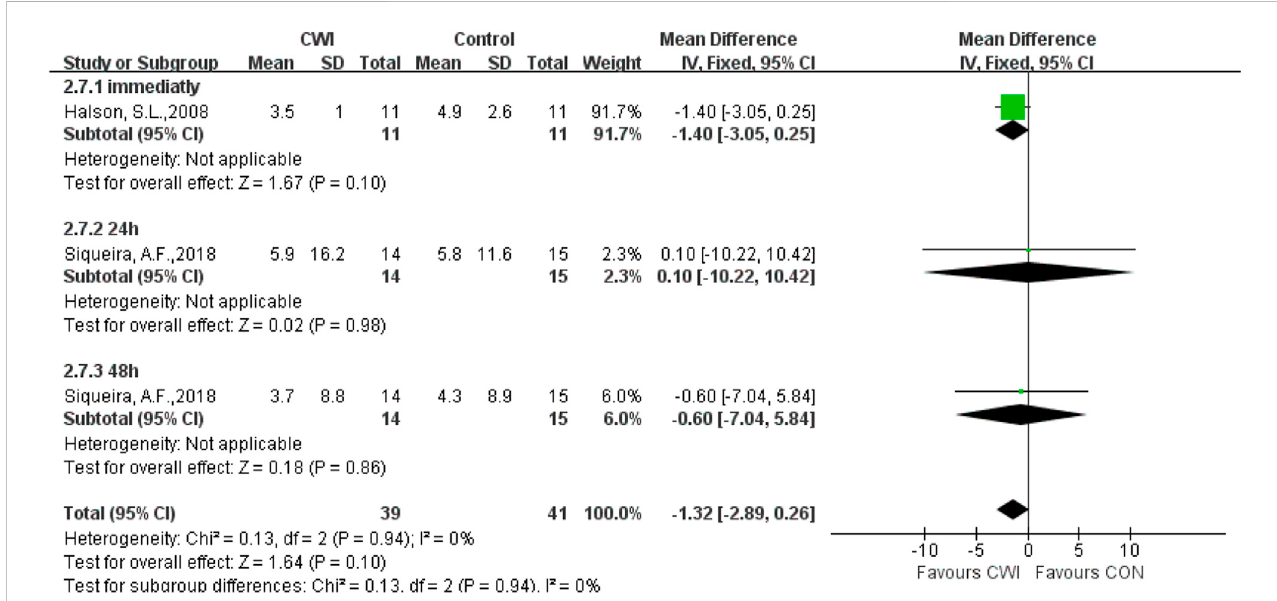
FIGURE 10 Forest plot of the comparison of CWI versus CON for measurement of IL-6.CWI = Cold water immersion, CON = Control, IL-6 = Interleukin